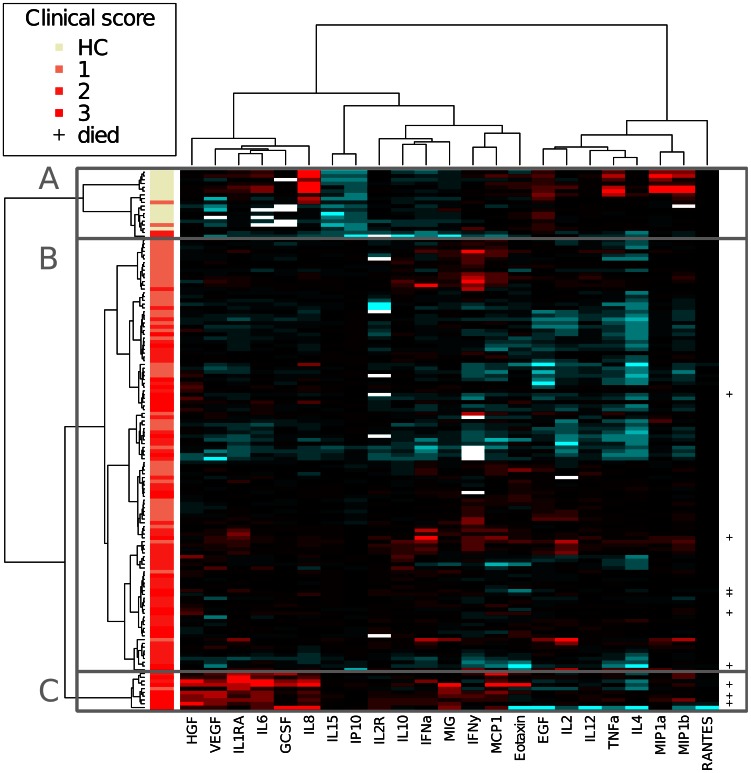
Heatmap of cluster analysis.A cluster analysis was performed with 23 cytokines, which resulted in a dendrogram indicated on the left of the heatmap. Every horizontal line indicates one patients. The vertical bar on the left of the heatmap indicates the disease severity of the patient. A: Cluster with mainly healthy controls and four dengue patients. B: Cluster with mild to moderately ill dengue virus infected patients. C: Cluster with severely ill dengue virus infected patients. Abbreviations: 1: non-severe dengue without warning signs. 2: non-severe dengue with warning signs. 3: severe dengue. +: patient died within 14 days after the onset of fever.